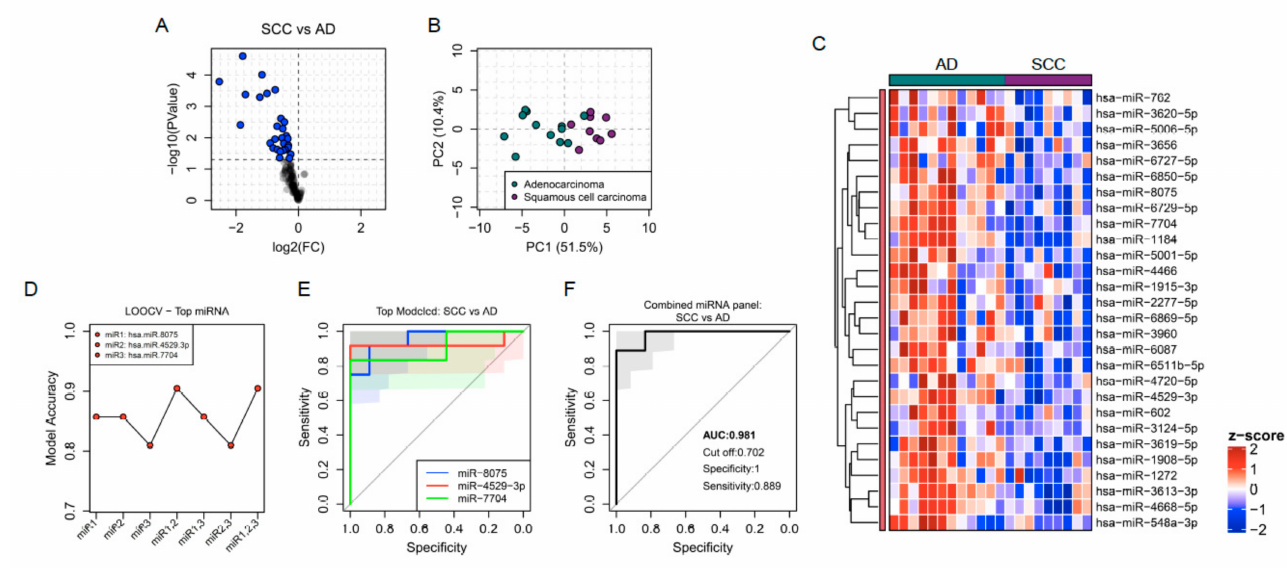
Figure 3. ( A ) Volcano plot showing fold change (FC) and statistical significance of individual miRNA levels in the breath condensate of SCC (squamous cell carcinoma) compared to AD (adenocarcinoma) patients. Blue dots represent negatively regulated miRNAs respectively ( p < 0.05). ( B ) Regulated miRNAs calculated PCA plots showing the PC1 and PC2 scores for individual SCC patients (purple dots) and AD patients (green dots). ( C ) Heatmap showing z-score of miRNAs regulated in EBC from SCC and AD patients. ( D ) Accuracy of specific cancer type prediction calculated by LOOCV models for individual miRNAs and for the four possible combinations. ( E , F ) ROC curves predicted for an individual ( E ) and combined miRNAs ( F ) selected through a random forest iteration